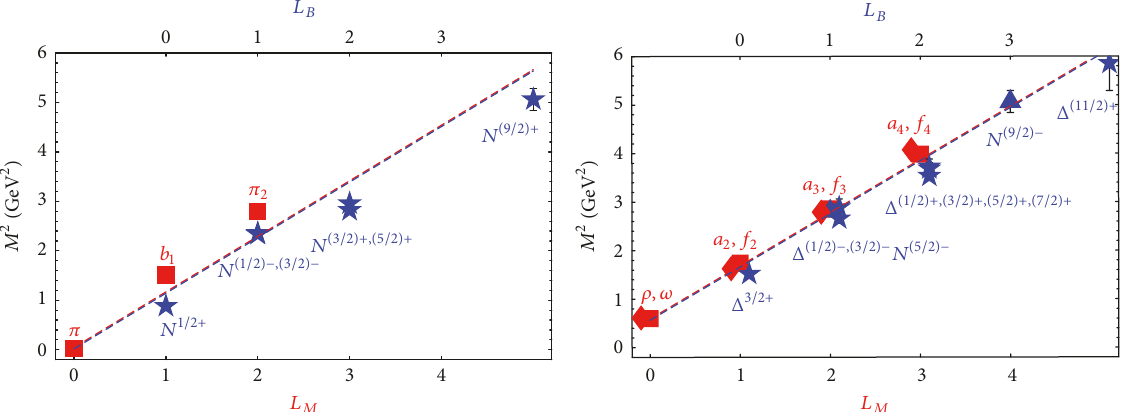
Figure 1: The 𝜋 − 𝑁 trajectory and the 𝜌 − Δ trajectory from